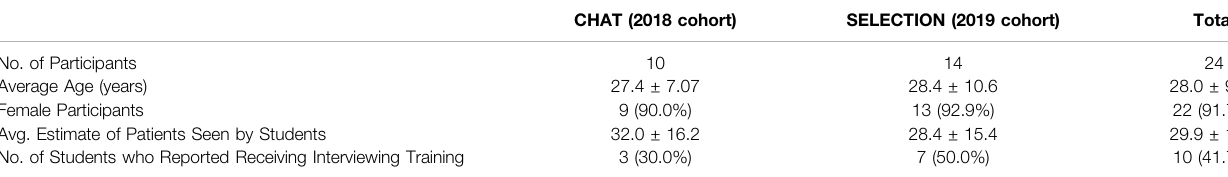
TABLE 1 | Demographic information for the students who participated in the